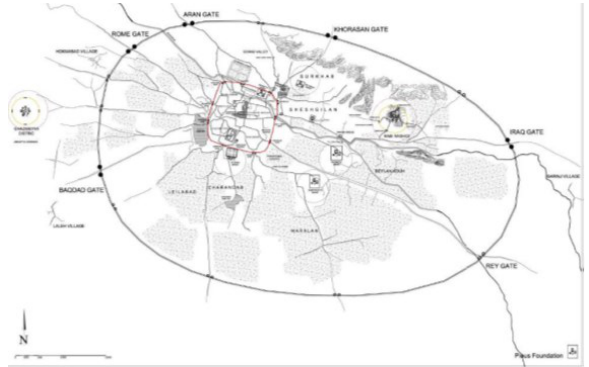
Figure 14. Sketch Map of Tabriz Metropolis, Ghazani wall and Urban Development during Ilkhanid Period (Jafarpour Nasser, 2011, p. 6).